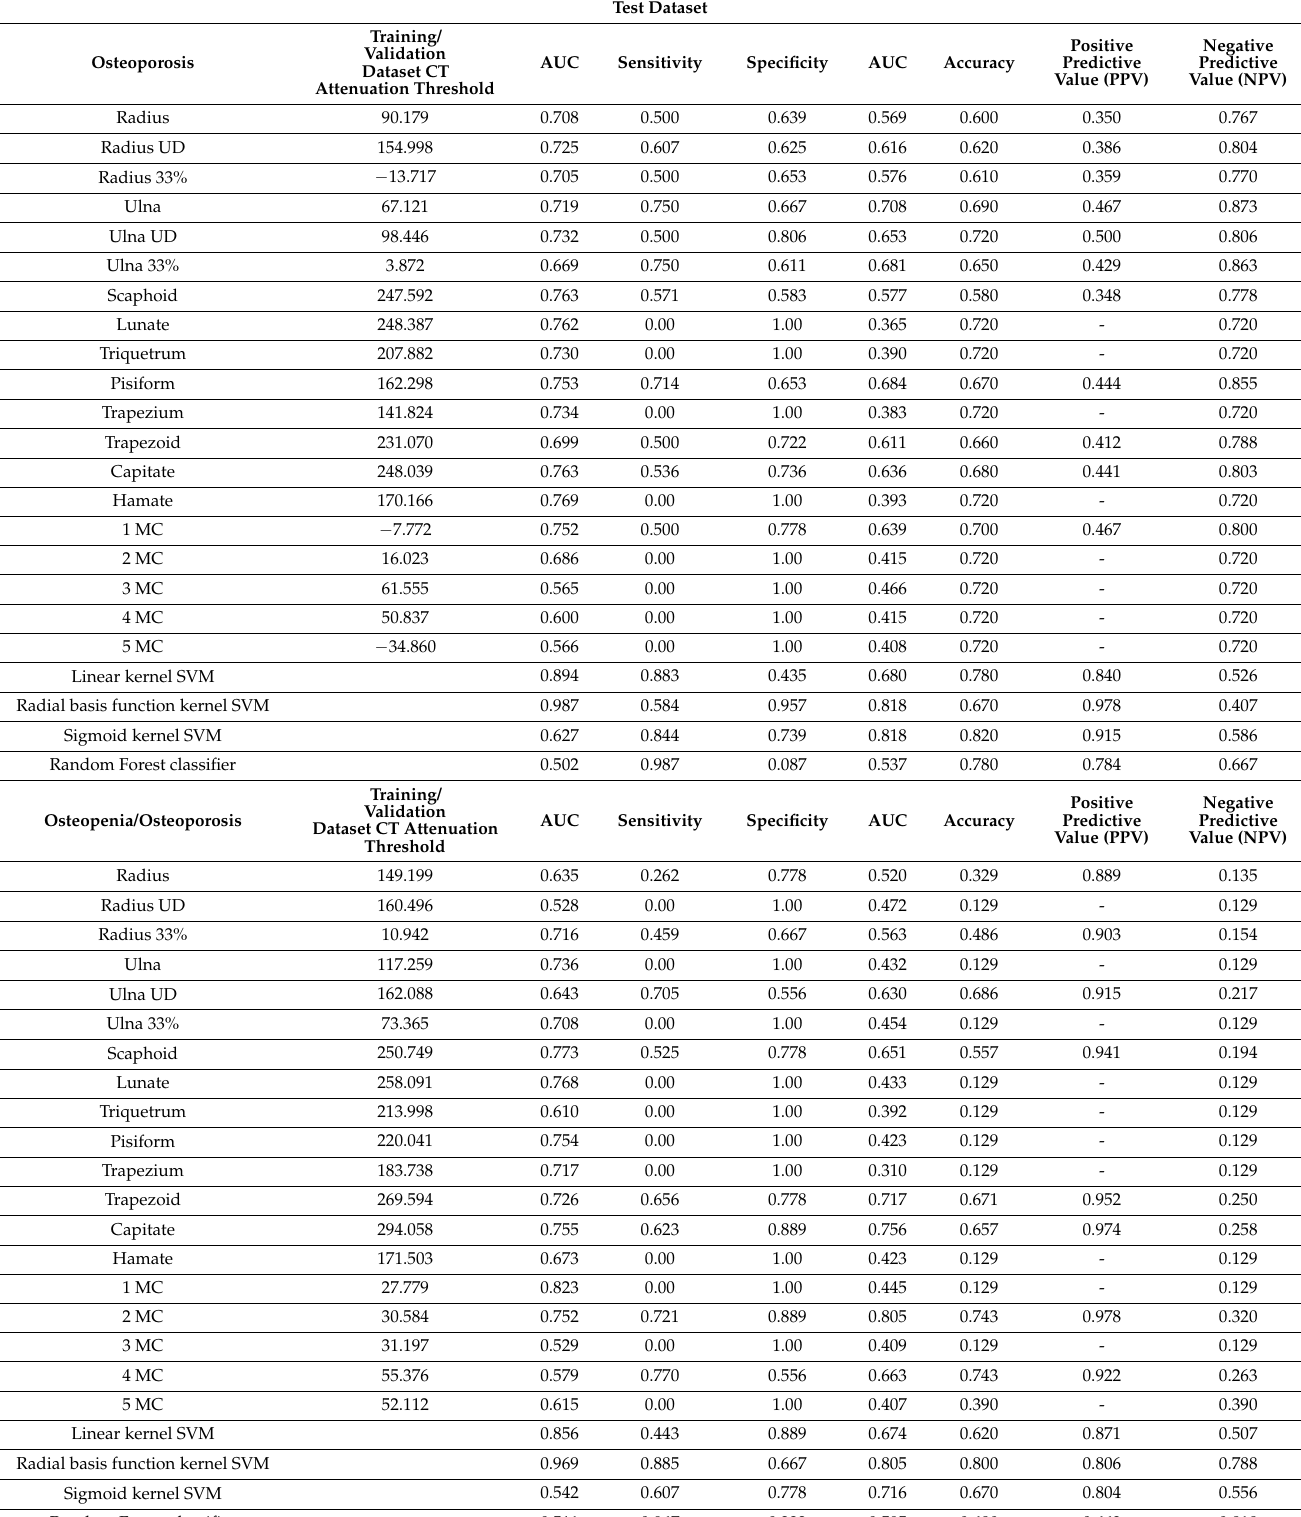
Table 4. Performance of the CT attenuation of each bone and multivariable machine learning models to predict osteoporosis and